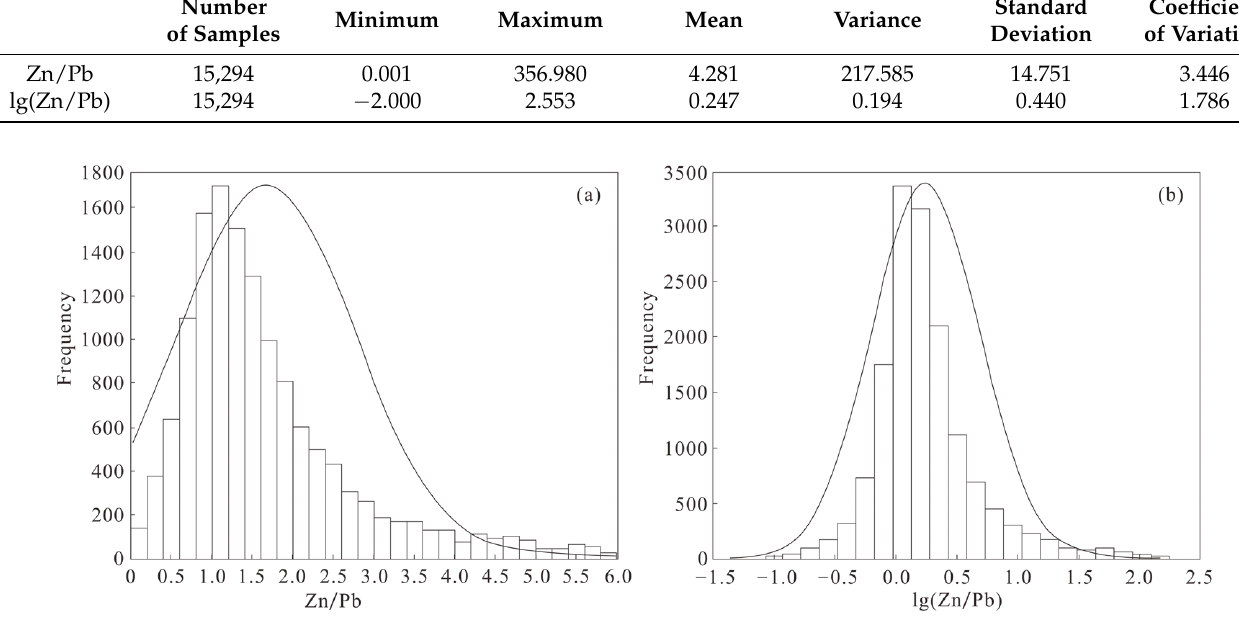
Figure 9. Semivariogram map of lg(Zn/Pb) values. ( a ) Omnidirectional semivariogram distribution map; ( b ) 100° direction semivariogram; ( c ) 10° direction semivariogram. The nugget/sill values in the 100° and 10° directions are similar, with values of 0.736 and 0.744, respectively, and the lg(Zn/Pb) values are moderately spatially dependent in both directions (Figure 9b–c and Table 5). The ranges in the 100° and 10° directions are 91.061 and 50.480 m, respectively, and the lg(Zn/Pb) values have a longer spatial correlation range in the 100° direction. Table 5. Results of semivariogram analysis. Directio n Nugget Sill 1.007 Cross-validation of the results of the semivariogram analysis using the Kriging evaluation (Table 5) shows that the mean error (ME) is close to 0, the RMSE is 0.296 and 0.297, the mean standard error (MSE; 0.000 and 0.001) is small and the RMSS is 1.009 and 1.007 and close to 1 in both the 100° and 10° directions, respectively. These parameters verify that the results of the variance function analysis are effective.